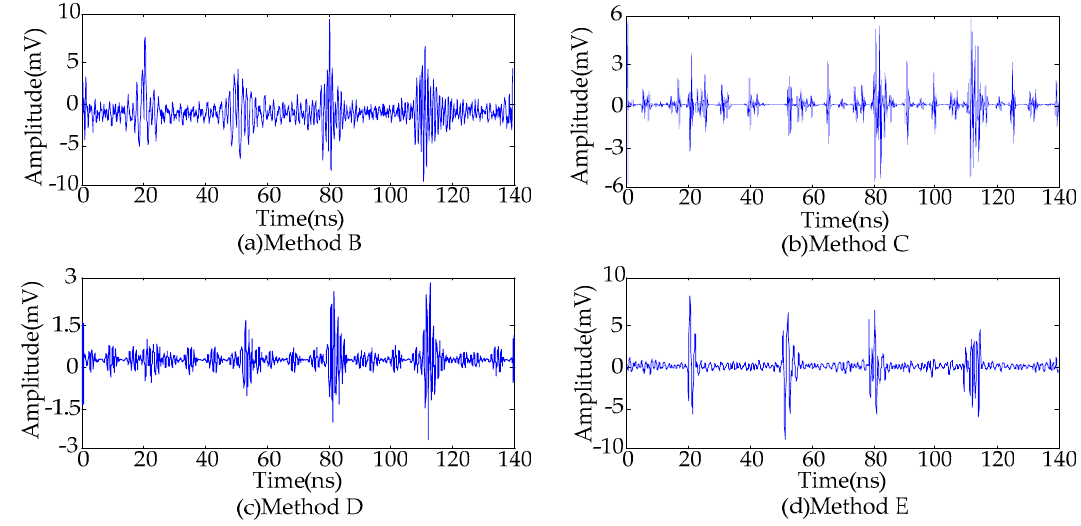
Figure 11. De-noising results by employing each method: ( a ) Method B; ( b ) Method C; ( c ) Method D; and ( d ) Method E. Table 4. De-noising evaluation parameters using each method.